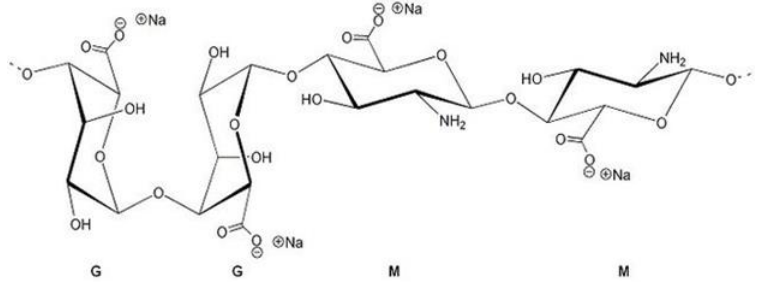
Figure 1. Sodium alginate structure.